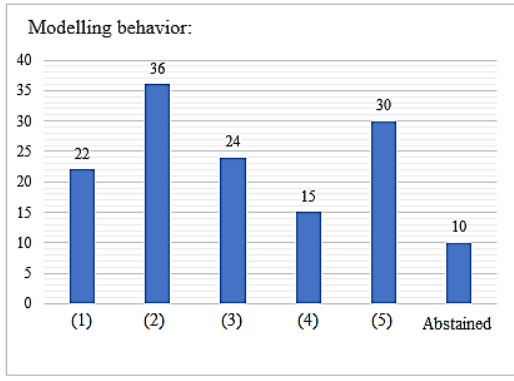
Fig. 6. Modelling system